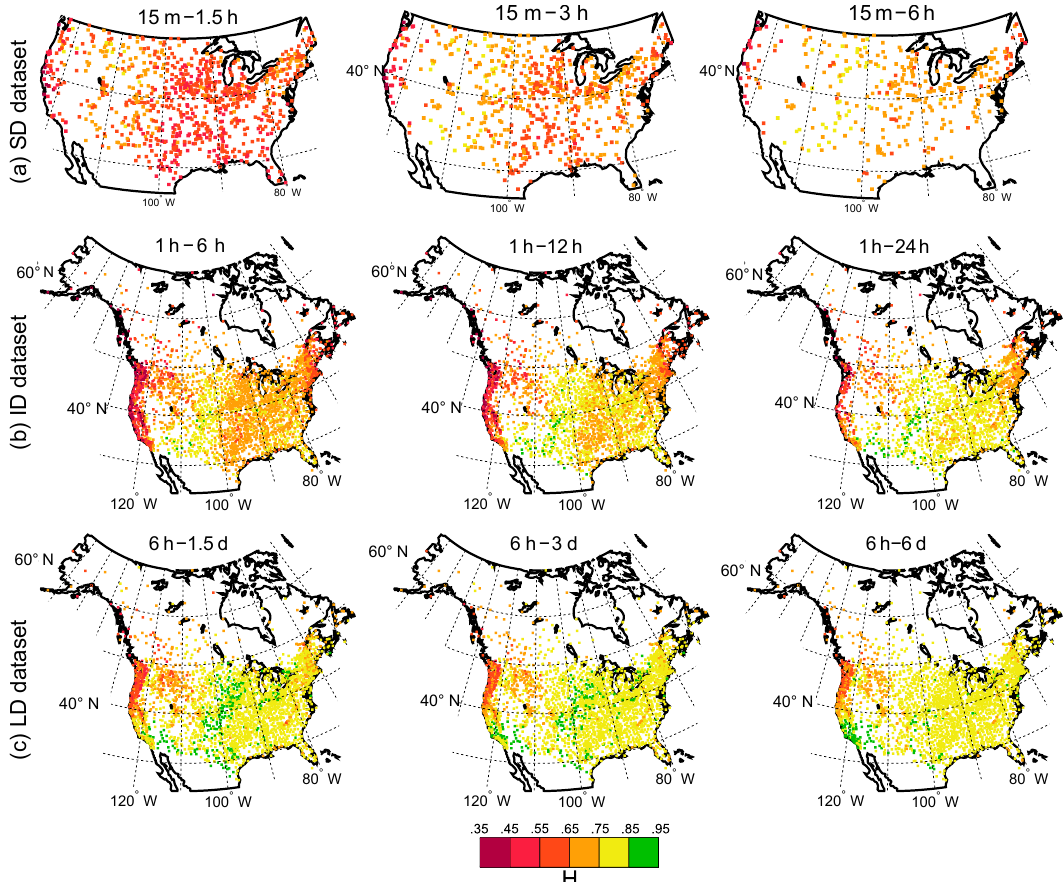
Figure 5. Spatial distribution of the scaling exponent for the first (i.e., with minimum d 1 ) 6-, 12-, and 24-duration scaling intervals (first, second, and third column, respectively) for SD, ID, and LD datasets (panels a , b , and c , respectively). These scaling intervals correspond to the first column of matrices in Figs. 2 and